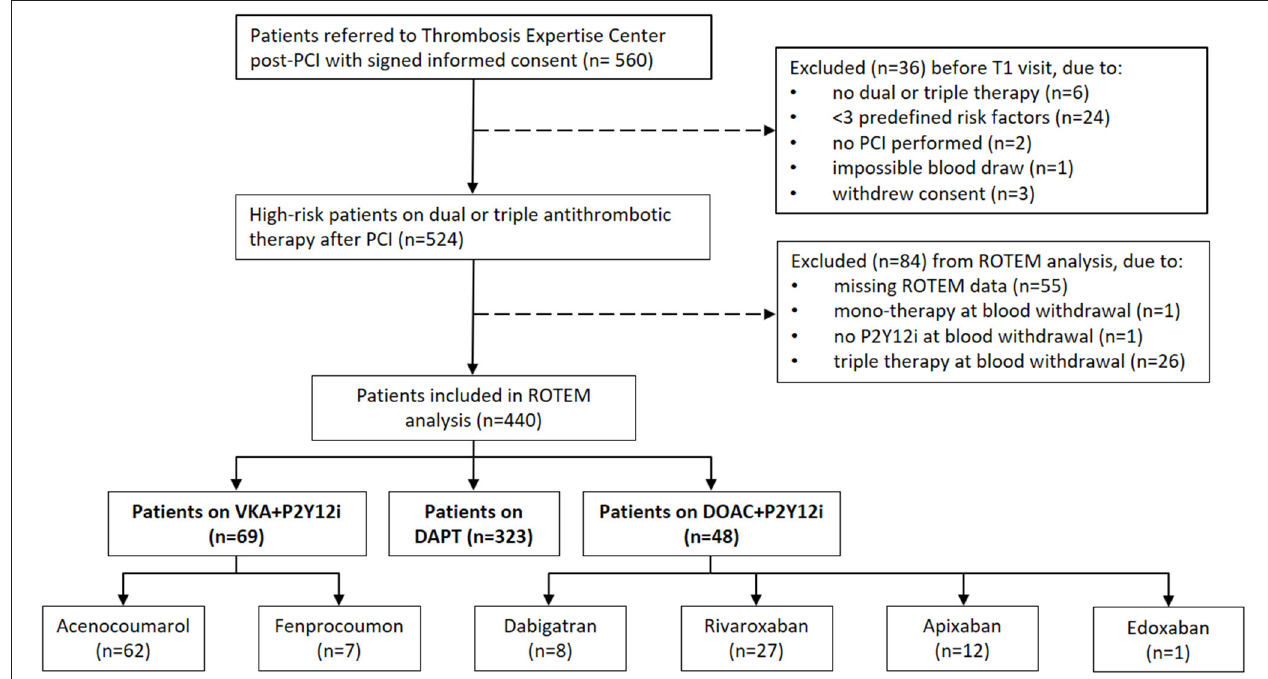
FIGURE 1 | Flow diagram of study inclusion and stratification in treatment groups. DAPT, dual antiplatelet therapy consisting of aspirin and a P2Y12-inhibitor (P2Y12i); DOAC, direct oral anticoagulant; PCI, percutaneous coronary intervention; ROTEM, rotational thromboelastometry; VKA, vitamin K antagonist.